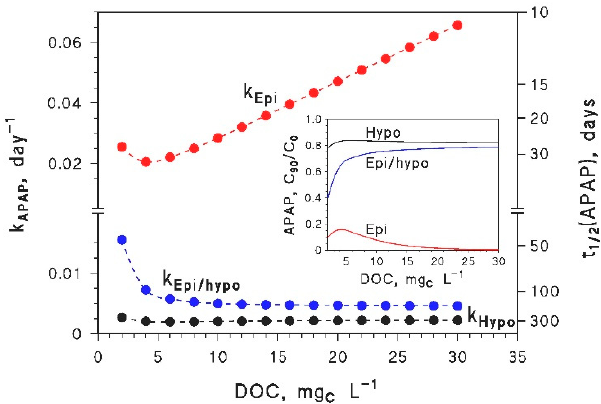
Figure 6. Trends of the photodegradation rate constants of APAP in the lake epilimnion ( k Epi ), hypolimnion ( k Hypo ), and whole water column ( k Epi / hypo , average depth d o = 40 m). The Epi / hypo kinetics was averaged as per Equation ( 14 ). In the photochemical model, to account for the sunlight intensity incident over the hypolimnion, the value of p ◦ ( λ ) (spectral photon flux density at the water surface) was replaced by p ◦ ( λ ) 10 − 100 A 1 ( λ ) DOC d th that accounts for sunlight absorption in the overlying epilimnion, with DOC × d th = 45 m mg C L − 1 and A 1 ( λ ) = 0.45 e − 0.015 λ . Figure insert: Concentration values of APAP after photodegradation for 90 days (C 90 ), with respect to the initial APAP concentration ( C 0 ), in the epilimnion (Epi), hypolimnion (Hypo), and the whole water column (Epi / hypo). The latter was averaged as per Equation ( 15 ), by assuming complete lake overturn at day 90. The ratio C 90 / C 0 is plotted as a function of the DOC, assuming DOC × d th = 45 m mg C L − 1 , and d o = 40 m as the average depth of the lake. Other water conditions for all simulations: 10 − 4 mol L − 1 NO 3 − , 10 − 6 mol L − 1 NO 2 − , 10 − 3 mol L − 1 HCO 3 − , 10 − 5 mol L − 1 CO 32 − . Photodegradation kinetics assumed mid-July irradiation conditions [27].